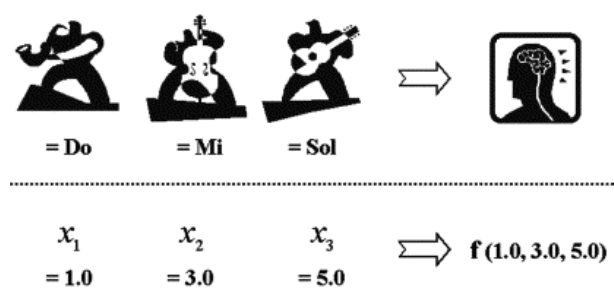
Figure 3. Analogy between music improvisation and engineering optimization